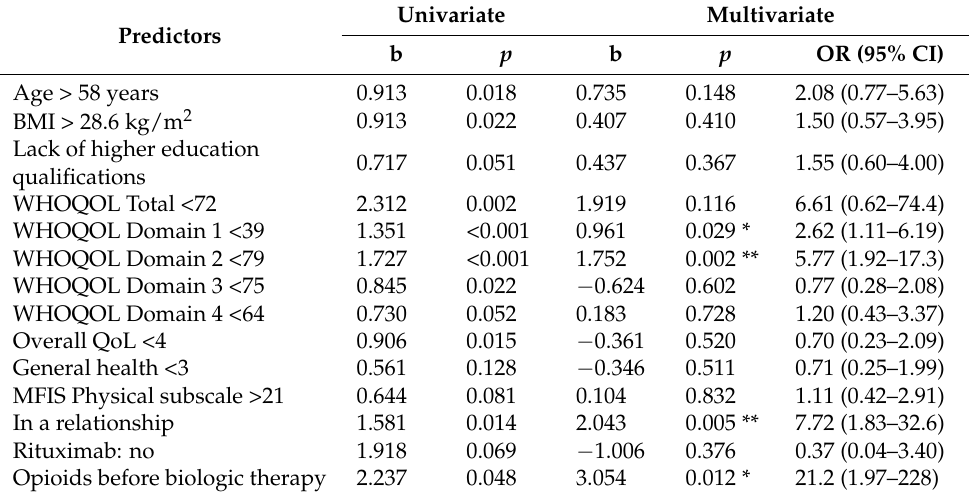
Table 9. A univariate and multivariate logistic regression analysis of the risk of incapacity for work from selected variables and estimated values of the odds